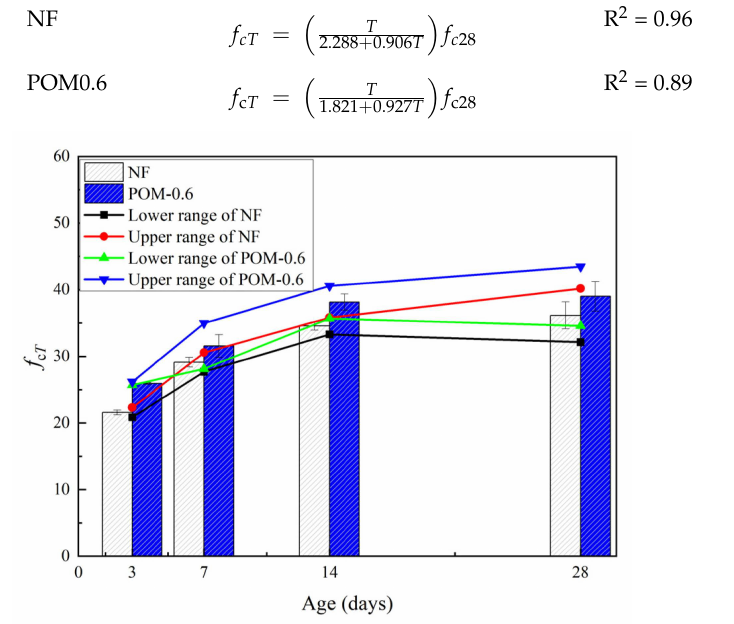
Figure 9. Test results of f cT for NF and POM0.6 SWSSC specimens with different concrete ages.